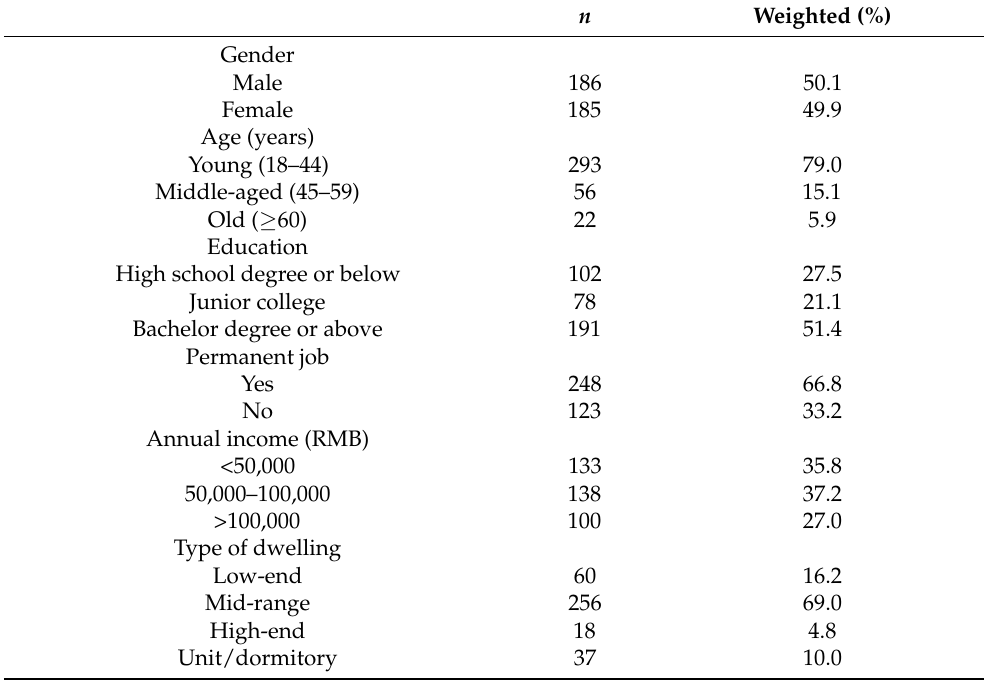
Table 2. Basic profile of the sample ( n = 371).